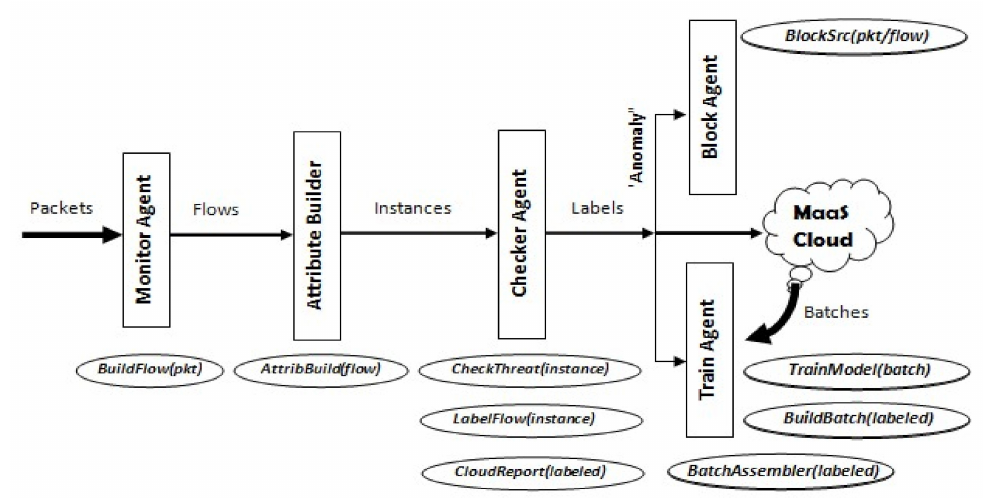
Figure 3. Proposed IDS Structure for IoT